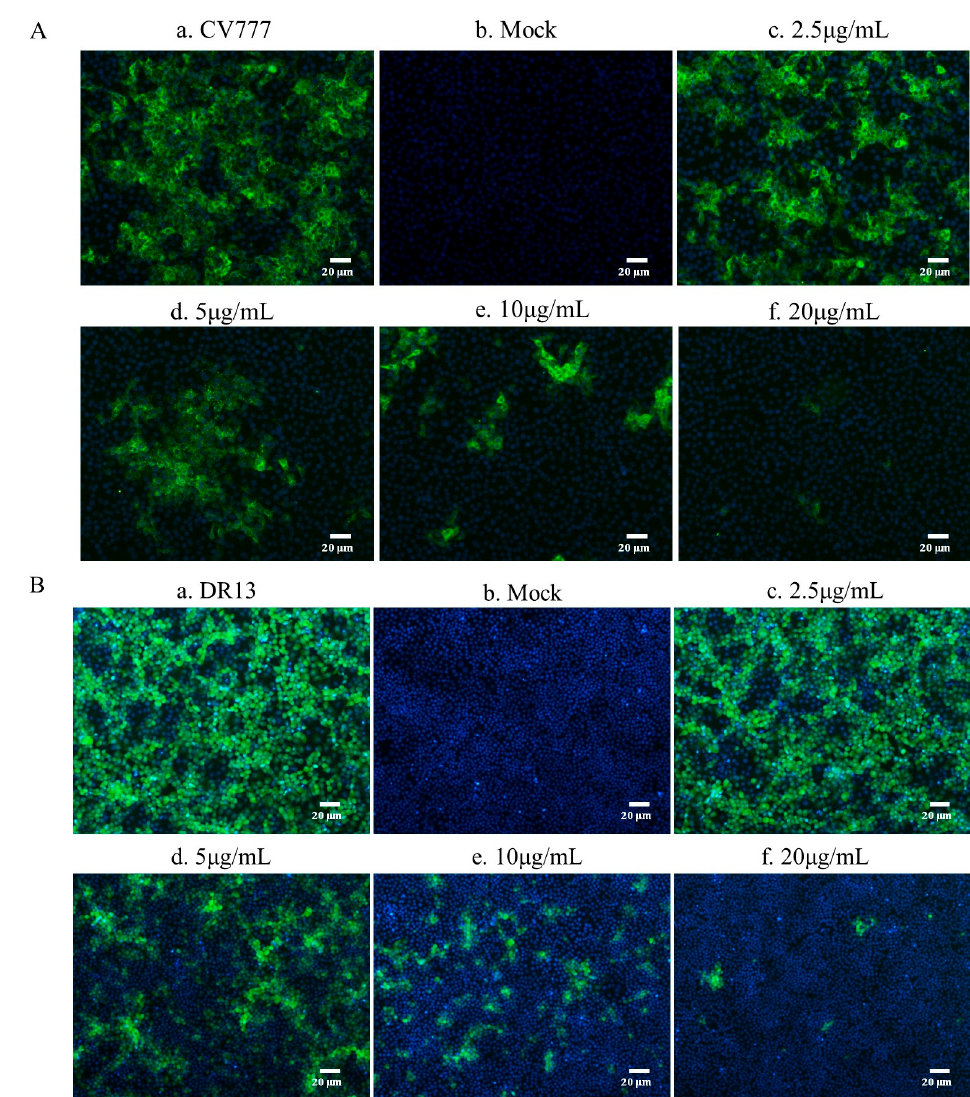
Figure 4. The inhibitory effect of Caerin1.1 against CV777 ( A ) and DR13 ( B ) strains. Fluorescence intensity of CV777/DR13 strain in the presence of Caerin1.1 at different concentrations. (a) Cells infected with porcine epidemic diarrhea virus (PEDV) of 200 pfu; (b) Mock-infected cells; PEDV were incubated with Caerin1.1 at the concentrations of 2.5 (c), 5 (d), 10 (e) and 20 (f) µ g/mL for 1 h. Scale bar, 20 µ